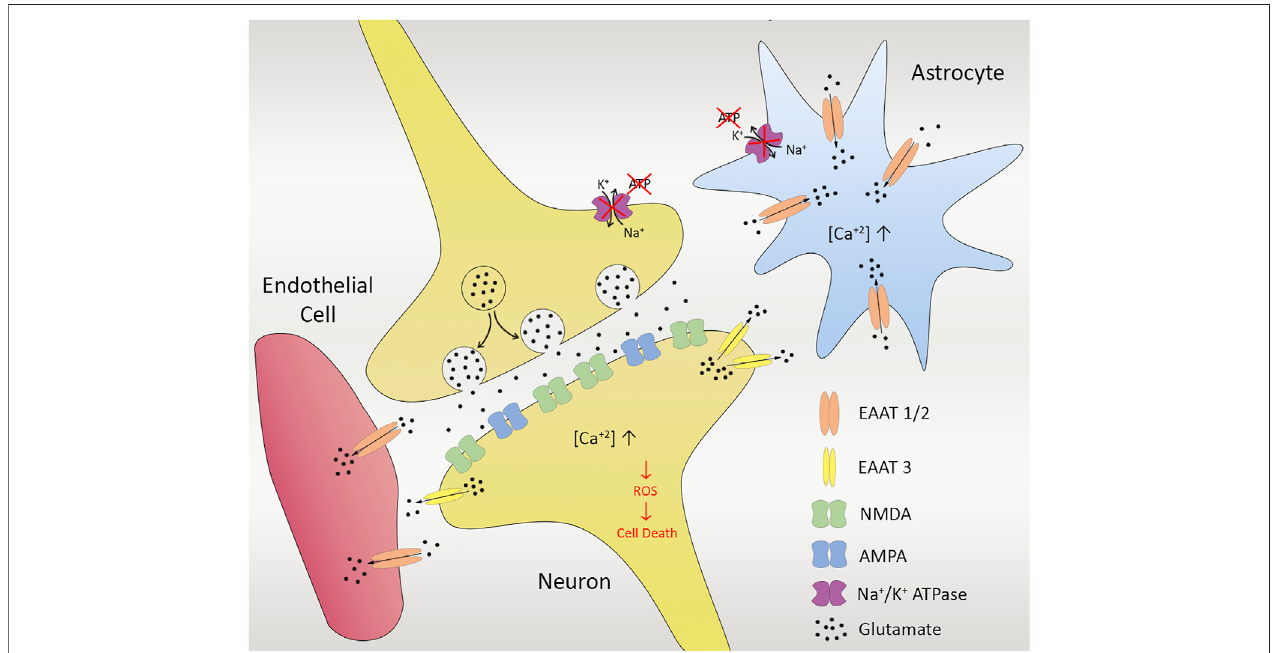
FIGURE 2 | Ischemia in cellular unit. Anoxic depolarization and decreased activity of glutamate uptake gives rise to enhanced glutamate levels, leading to calcium in fl ux via NMDA receptors. Excessive glutamate released from presynapse of the neuron also leads to Na + -dependent excitatory amino acid transporters (EAATs) in astrocytes(EAAT1/2)aswell asneurons(EAAT3).Insuf fi cient energy andlackofionpump functioningcause massiveincrease intheintracellular Ca 2+ ,activating protein kinases and some other downstream Ca 2+ -dependent enzymes, damaging the cell membrane, resulting in more Ca 2+ entry into the cell, release of free radicals as well as reactive oxygen species (ROS) that gives rise to cell death in the